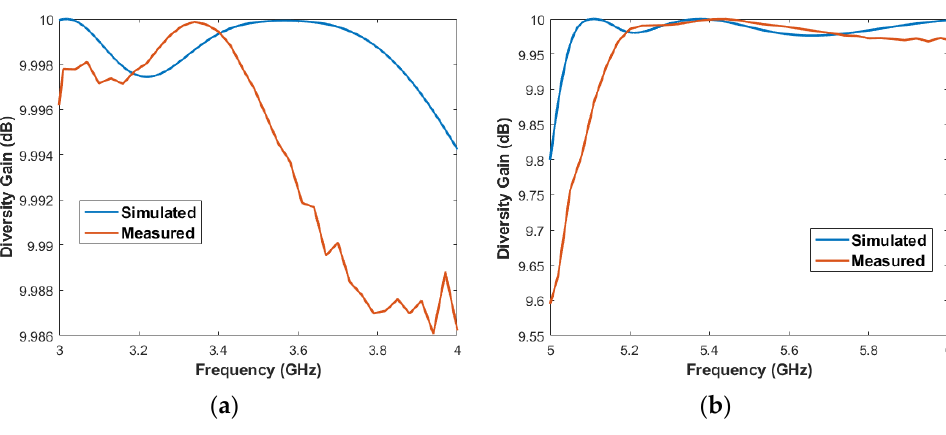
Figure 16. Measured DG results for the ( a ) first and ( b ) second operating bands.